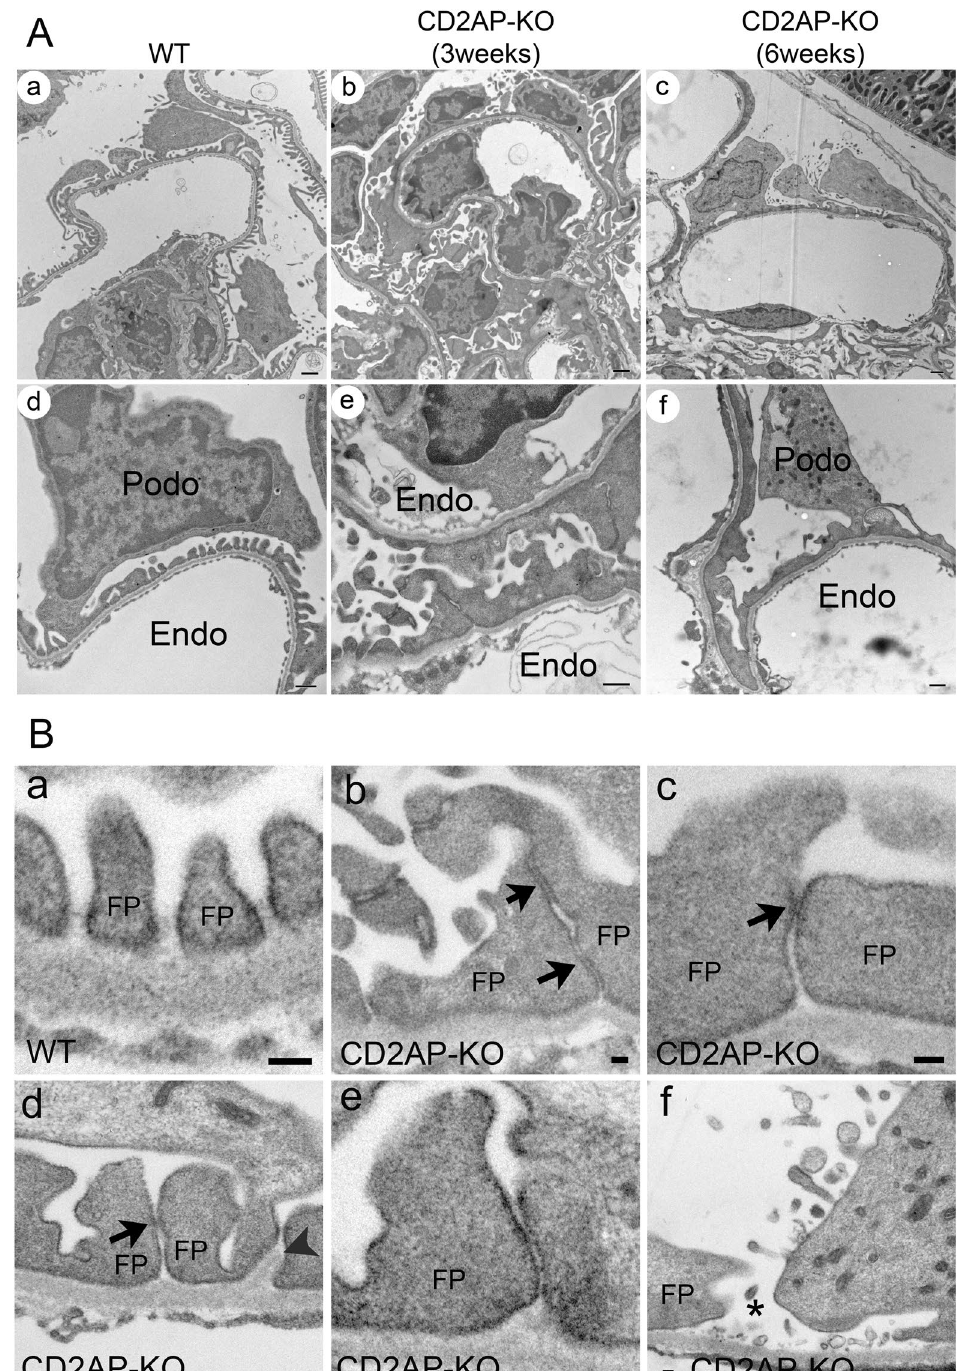
Figure 4. Podocyte morphology in WT and CD2AP deficient mice by TEM. ( A ) Representative TEM images of WT (a, d), 3 week-old Cd2ap -KO (b, e) and 6 week-old Cd2ap -KO (c, f) kidneys. WT glomeruli (a, d) show well-organized interdigitated foot processes lining up along the capillary wall with uniformly spaced slit diaphragms (SDs) between adjacent foot processes. Glomeruli of both 3 week- (b, e) and 6 week-old (c, f) Cd2ap -KO mice show massive foot process effacement, which is associated with the disappearance of the filtration slit and SDs between foot processes. Intracellular junction-like structures are frequently formed between effaced podocytes. Scale bars, 1 μ m in upper panels; 500 nm in lower panels. ( B ) Representative TEM images of podocyte slit pores in WT (a) and Cd2ap -KO (b–f) mice. Intact slit pores are seen in WT mice (a). In Cd2ap -KO mice, narrow slit pores are frequently seen (b–e) with some cell contact area (black arrows). GBM expansion into the space between foot processes is observed (d, arrowheads). A widened slit pore with no SD is also observed (f, asterisk). Scale bar, 100 nm. Podo, podocyte; FP, foot process; Endo, endocapillary